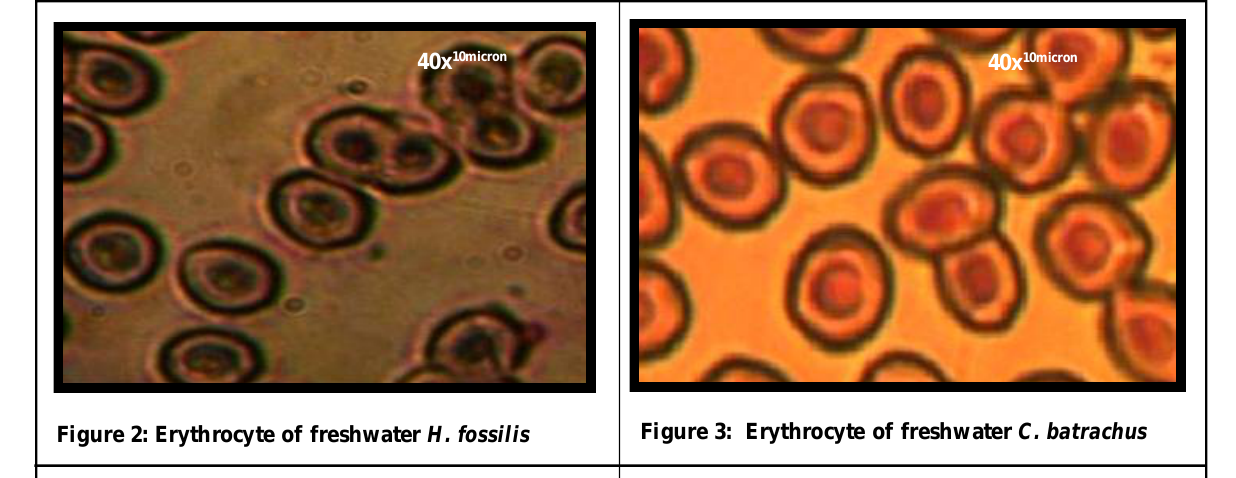
Figure 2: Erythrocyte of freshwater H. fossilis Figure 3: Erythrocyte of freshwater C. batrachus